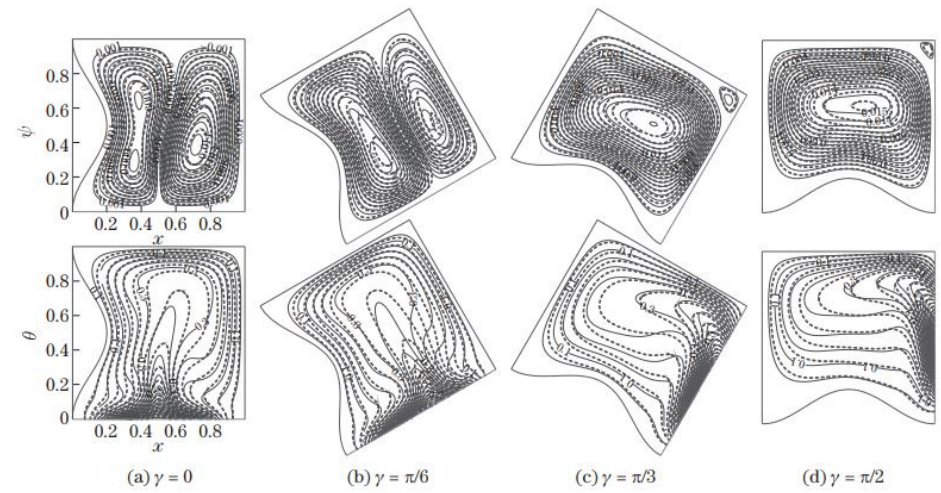
Figure 9. Effect of the inclined cavity on heat transfer [85]. The angle at which the cavity is tilted is an excellent control parameter that can im- prove how heat is distributed. Except for the case in which the angle is 45 degrees, the average Nusselt number goes down whenever the nanoparticle volume fraction is up. The processes of heat transport have also been investigated by researchers [105] using a slanted square cavity. The impact on the circulation of heat is depicted in Figure 10.